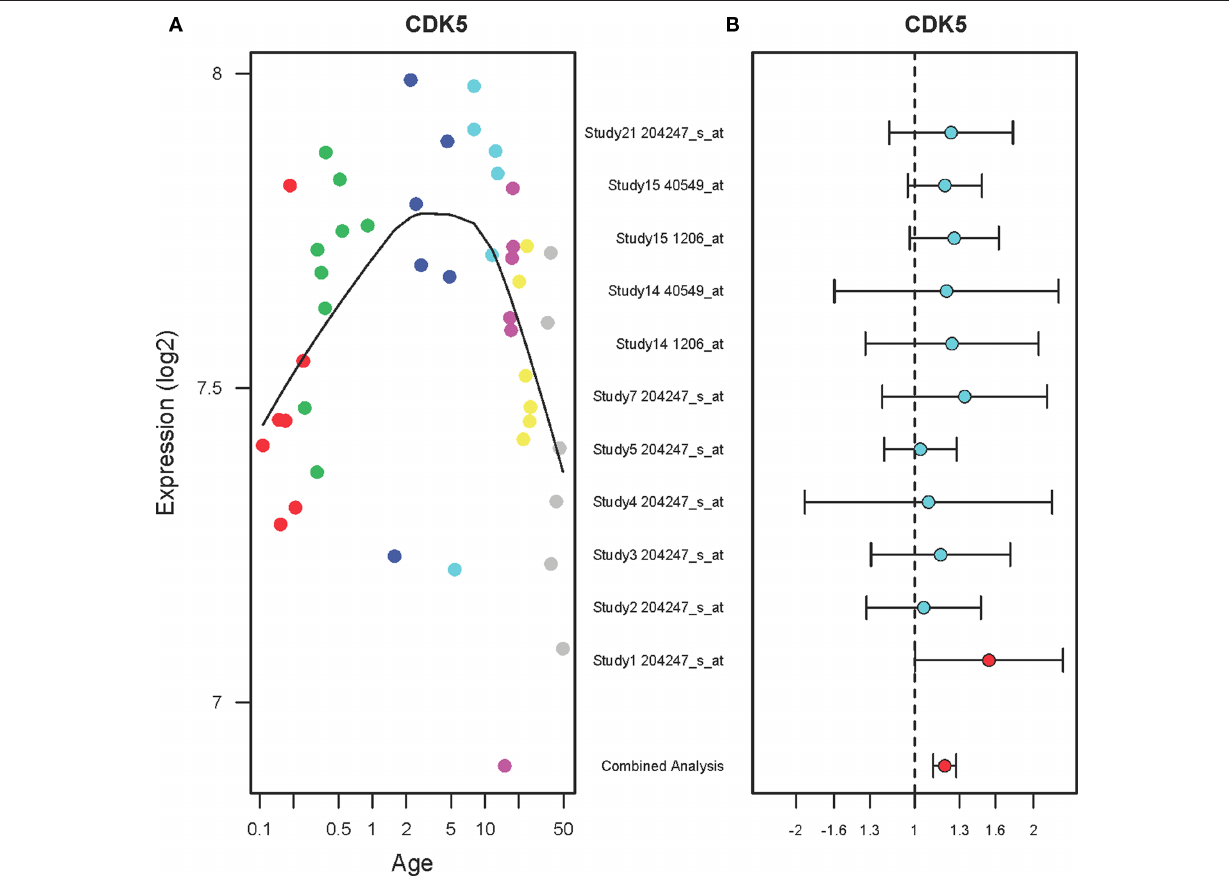
Figure 2 | The expression profiles of CDK5 in the PFC of normal developing individuals and suicide victims. (A) The scatter plot with a locally weighted scatter plot smoothing (LOWESS) line demonstrates inverted U-shape expression pattern of CDK5 in the PFC of normal humans ranging in age from birth to 49 years. Points are colored by the predefined age groups: red = neonate, green = infant, blue = toddler, light blue = school age, pink = teenage, yellow = young adult, gray: adult. (B) The plot with fold changes